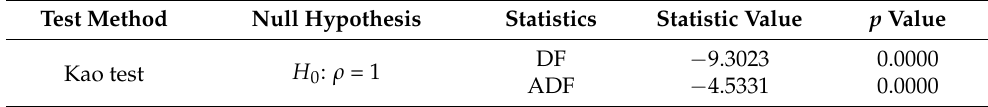
Table 3. Cointegration